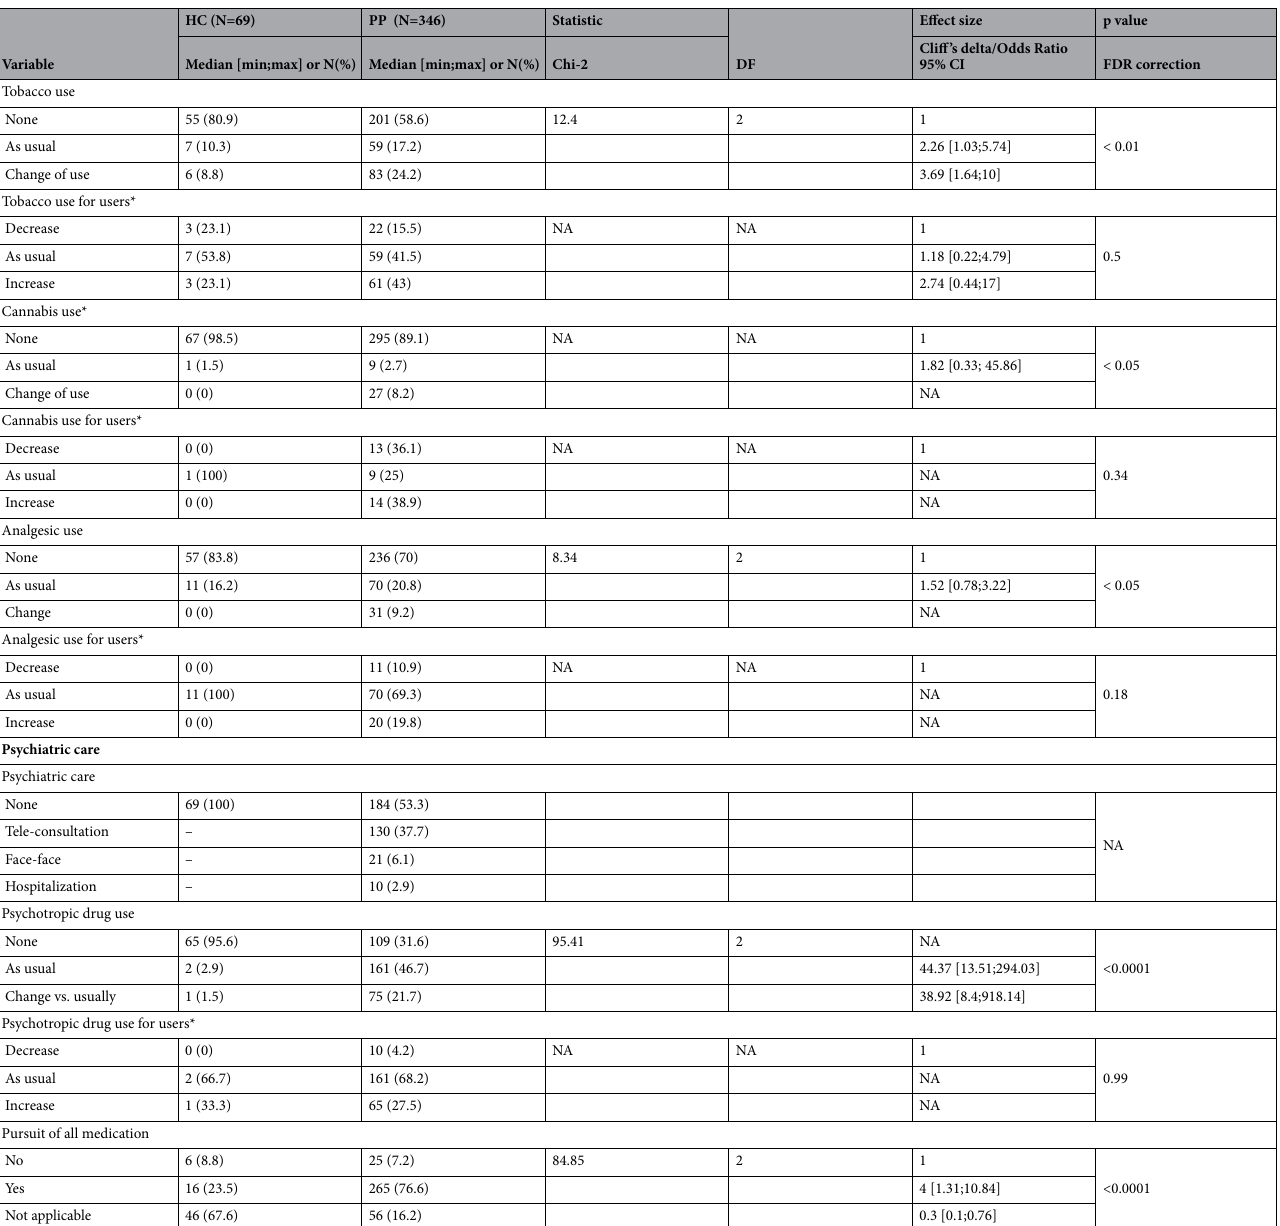
Table 1. Univariate comparison between HC and PP. Chi-square statistics, associated degree of freedom and Cliff’s non-parametric effect size or Odds Ratio and 95% confidence intervals are presented according to the test used (Kruskal–Wallis test, or Chi square test). DF degree of freedom, HC healthy controls, PP psychiatric patients, NA not available, «*» Fisher’s exact